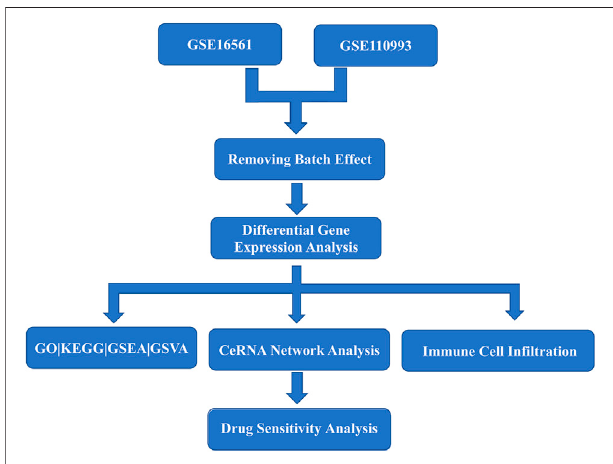
FIGURE 1 | Flow chart of overall